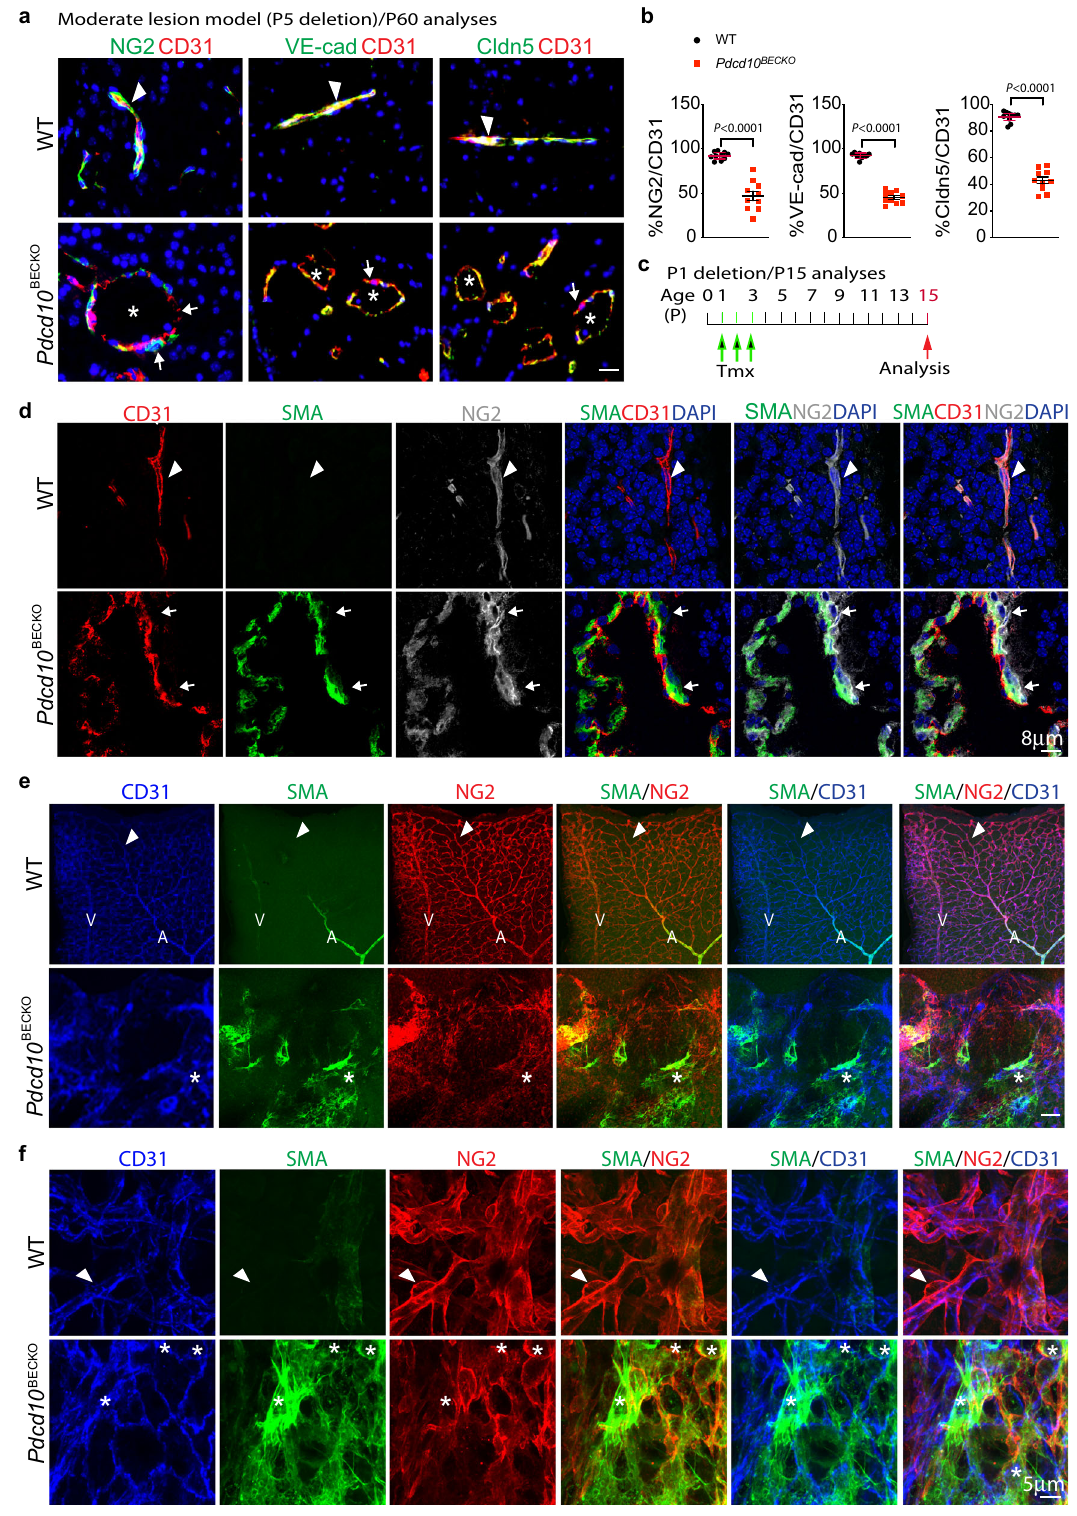
To further evaluate the rescue effect of Cav1 deletion on CCM lesion formation and progression, we employed two-photon microscope imaging for the dynamic association of EC-pericyte and vascular structures. To this end, Ccm3 in mice was deleted at P5 followed by imaging of CCM lesions at age of 2-month old upon co-injection of NeuroTrace 500/525 and Texas Red IV dye (Note: The moderate but not the severe CCM model was